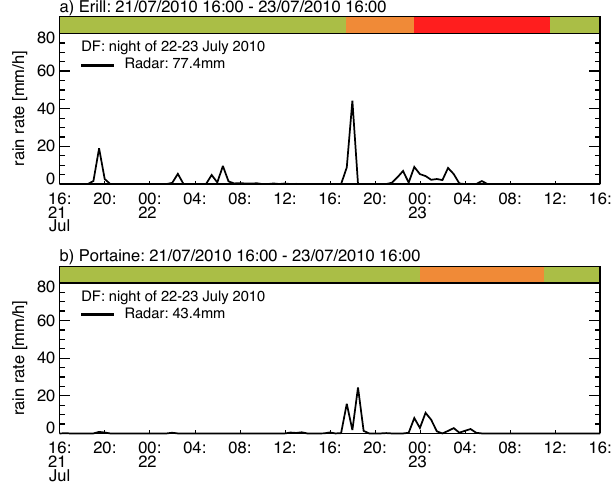
Figure 14. Same as Fig. 13 but for the event of 21–23 July 2010 in the Erill torrent (a) and in the Port Ainé subbasin (b) . The solid black lines show the estimated rain rate in the